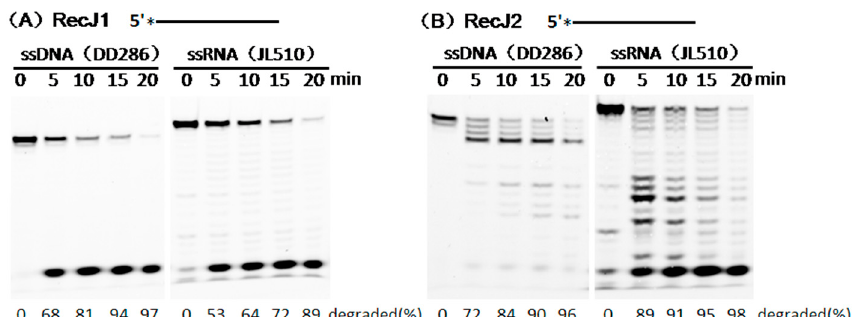
Figure 3. Preferences for (deoxy)ribose of two MjaRecJs. Reactions were performed at 55 °C with increasing time using 200 nM 23 nt 5 ′ -FAM labeled ssDNA and ssRNA as substrates in their respective reaction buffer. 40 nM MjaRecJ1 and 50 nM MjaRecJ2 were used, respectively, in each reaction. The degraded amount of substrate was quantified at each time and listed at the bottom of the panel.